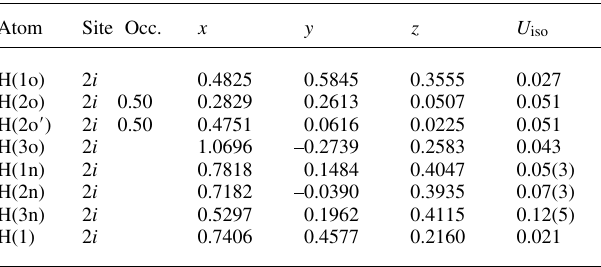
Table 2. Atomic coordinates and displacement parameters (in Å 2 )